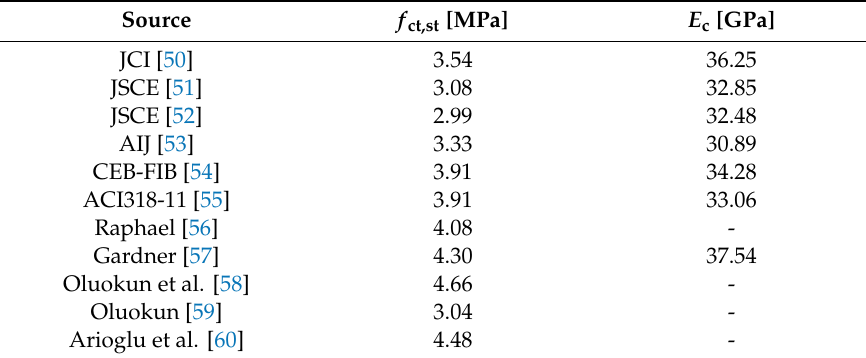
Table 7. Results of mechanical properties f ct,st and E c for coe ffi cients k, n, α , β .